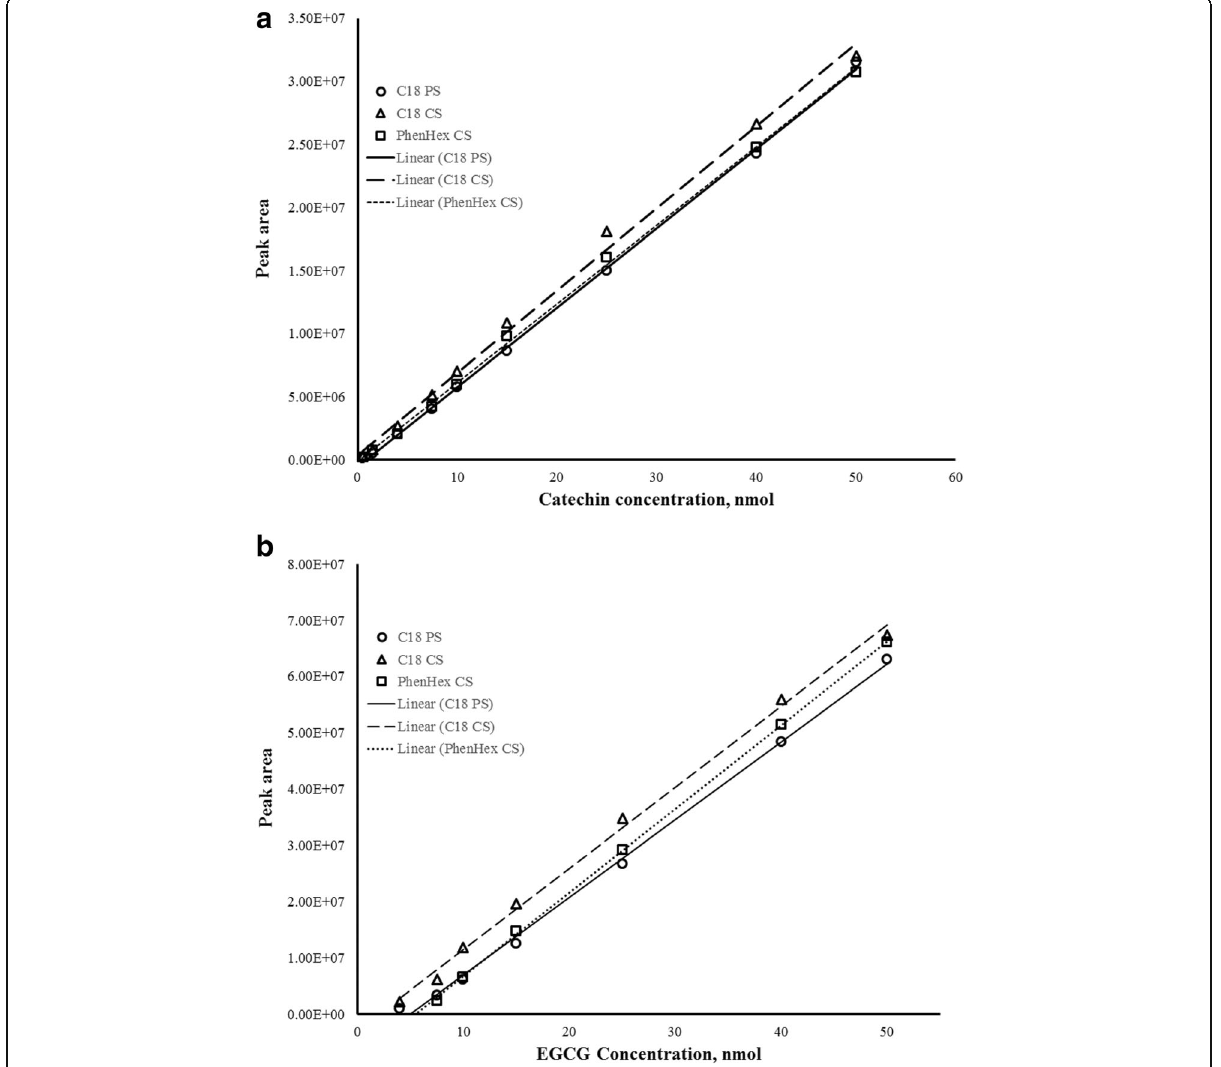
Fig. 2 HPLC calibration curves for antioxidants catechin ( a ) and EGCG ( b ) using C18 porous silica (solid lines), C18 core-shell (coarse dashed lines) and phenyl-hexyl core-shell (fine dashed lines) columns with CUPRAC post-column